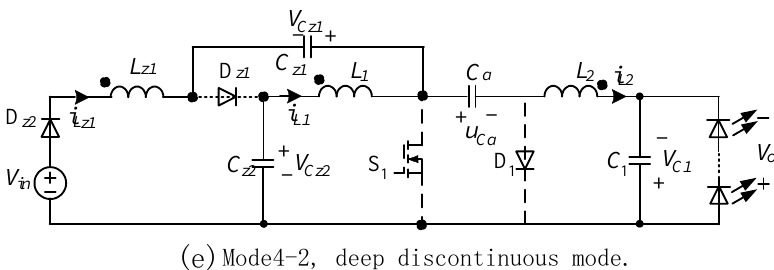
Mode4-2, deep discontinuous mode. Figure 2. Equivalent circuit of the proposed driver with four possible work Figure 2. Equivalent circuit of the proposed driver with four possible work modes. The proposed converter contains three work modes as in Figure 2a – c in CCM, while it contains one more mode in Discontinuous Conduction Mode (DCM), which can be Fig- ure 2d or Figure 2e according to the load. The arrows in Figure 2 indicate the actual direc- tion of the loop current, and the positive and negative signs also indicate the actual direc- tion of the element voltage. The work details are as follows: Mode 1[ t 0 – t 1 ]: The switch S 1 is turned on at t 0 , and D z1 is reverse-biased for V cz2 > V cz1 . D 1 is also off by withstanding V ca . There are three current loops in this mode, and all the inductors are charged, while all the capacitors are discharging. The input voltage V in and